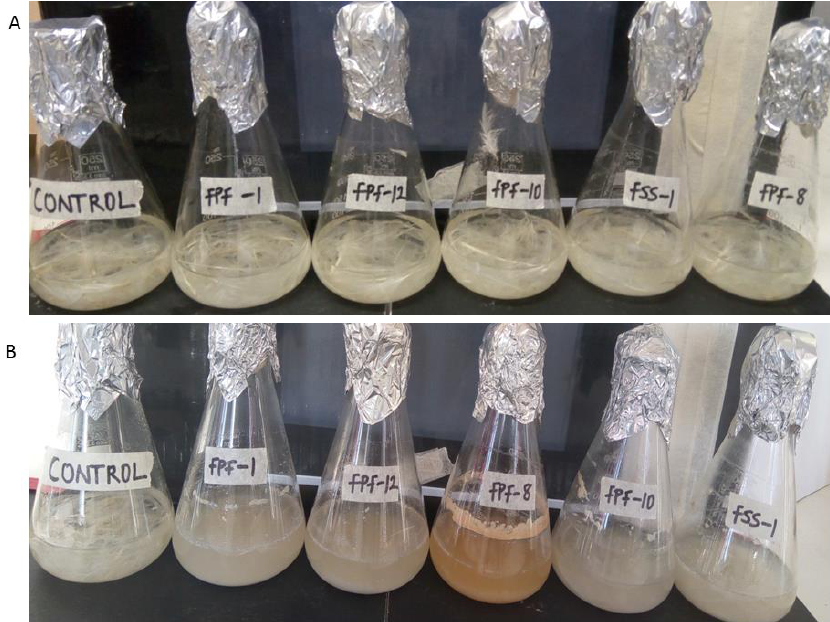
Figure 1. Biodegradation of intact chicken feathers by the keratinolytic bacterial isolates: ( A ) before incubation; and ( B ) after 96 h of incubation.